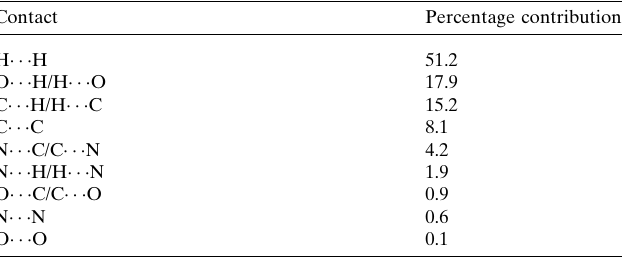
Fig. 6. H (cid:2) (cid:2) (cid:2) H interactions, which are located in the middle region of the fingerprint plot, contribute the most to overall crystal packing, with 51.2% (Fig. 6 b ). The O (cid:2) (cid:2) (cid:2) H/H (cid:2) (cid:2) (cid:2) O contacts contribute 17.9% (Fig. 6 c ) to the Hirshfeld surface, while the C (cid:2) (cid:2) (cid:2) H/H (cid:2) (cid:2) (cid:2) C contacts contribute 15.2% (Fig. 6 d ), resulting in a pair of distinctive wings. The C (cid:2) (cid:2) (cid:2) C interactions account for 8.1% of the Hirshfeld surface. The percentage Table 2 Percentage contributions of interatomic contacts to the Hirshfeld surface of the title compound.